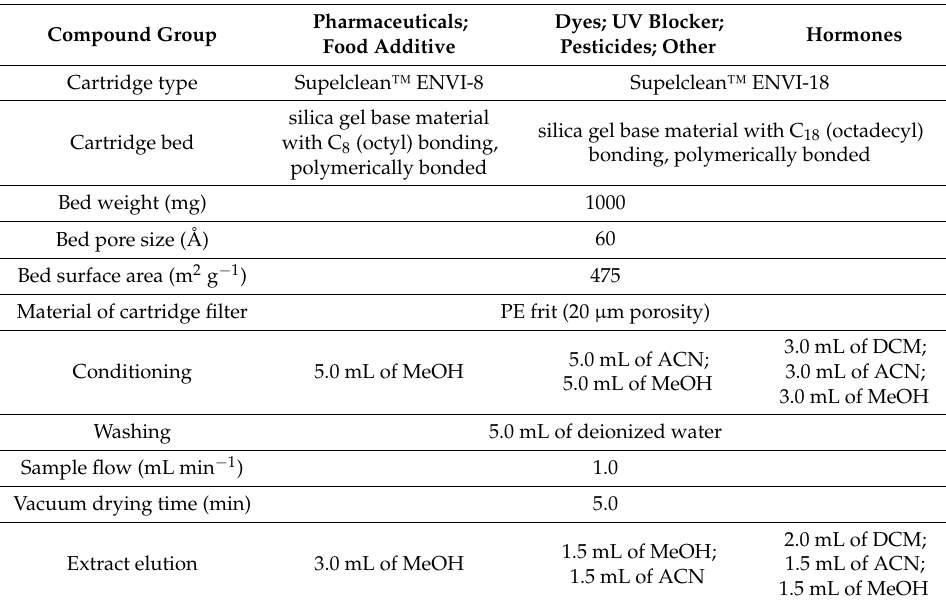
Table 2. Solid phase extraction details for different compound